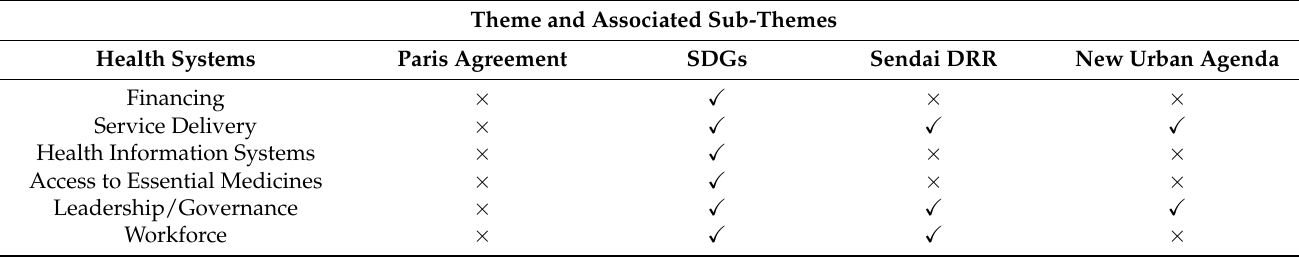
Table 2. Analysis of WHO building blocks across all four agreements.